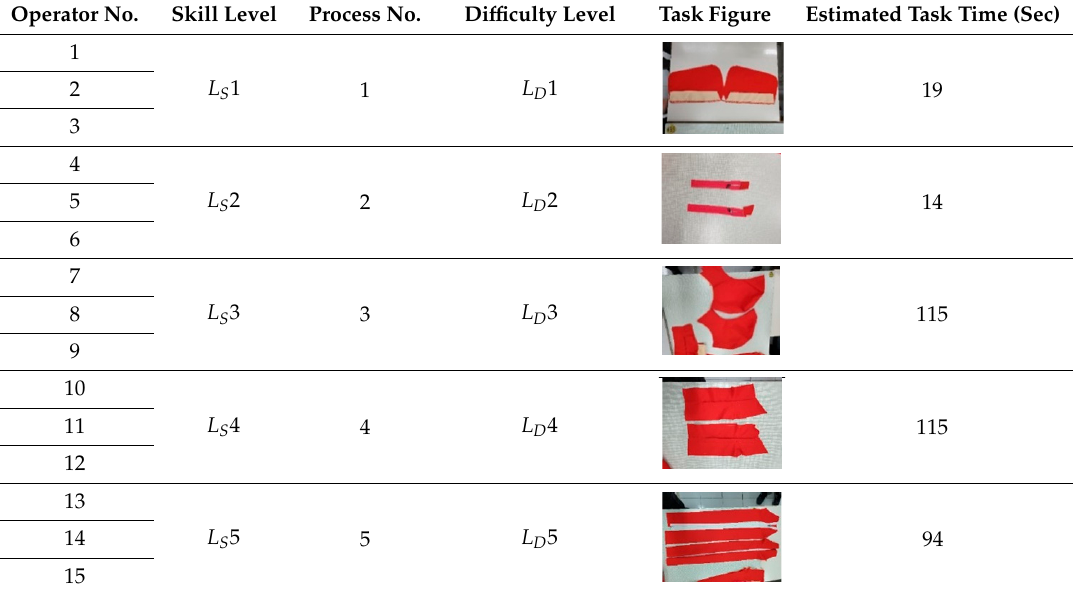
Table 1. Experimental operators and selected tasks.